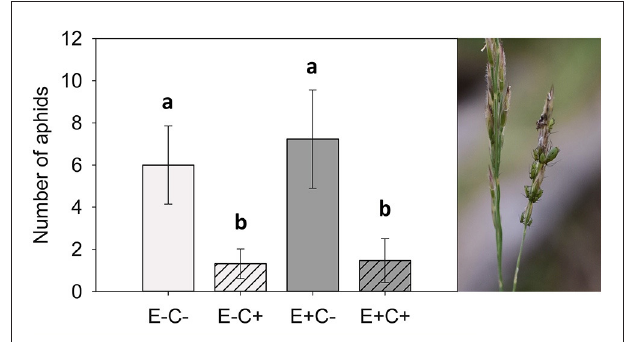
FIGURE 1 | Number of aphids on the study plants. There were over 4.5 times more aphids on the plants without the Claviceps (C) infection. Epichloë (E) did not affect the amount of aphids on the plant. Generalized linear model, Tukey-adjusted pairwise comparisons: E–C– and E–C + : t 167 = 3.48, p = 0.004; E–C– and E + C–: t 167 = 1.13, p = 0.670; E–C– and E + C + : t 167 = 3.93, p = 0.001; E–C + and E + C–: t 167 = 4.36, p = < 0.001; E–C + and